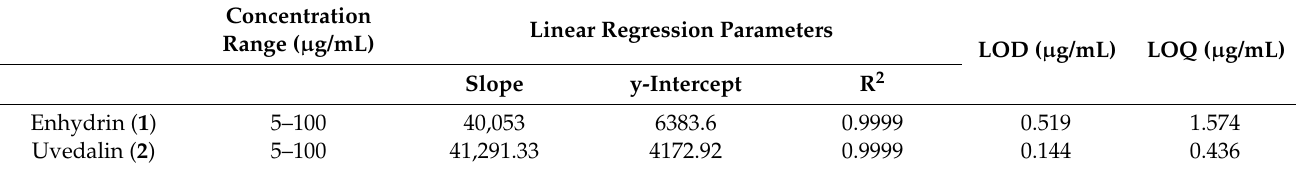
Table 2. Linear regression analysis parameters for the determination of compounds 1 and 2 .